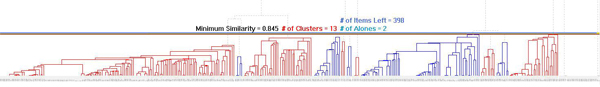
Functional clustering (biological process) of Clus1 of Home sapiens. Table 4 provides the details on functional cohesiveness.